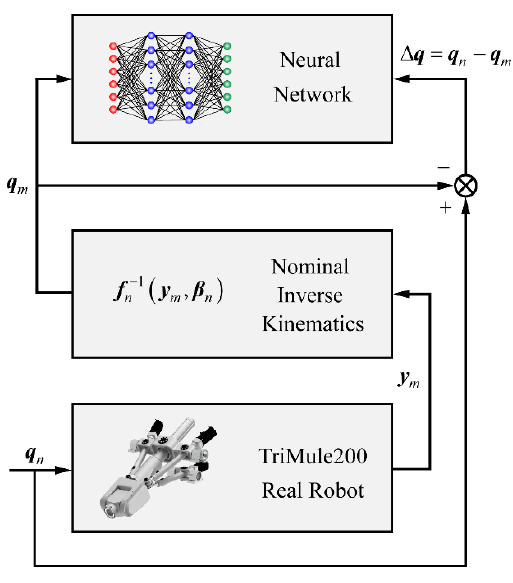
Figure 6. The principle of network training.